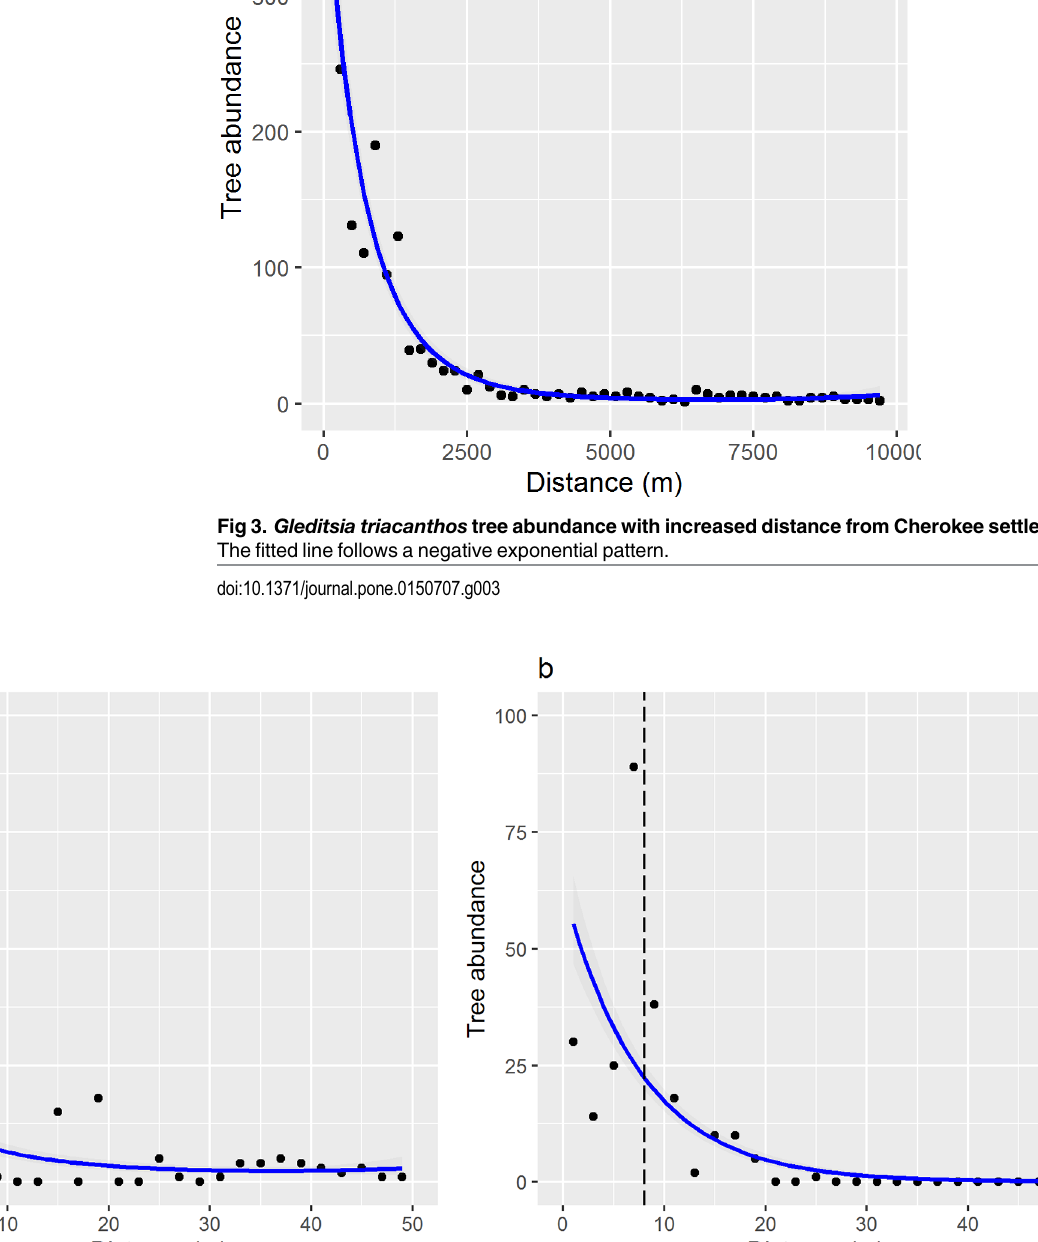
PLOS ONE | DOI:10.1371/journal.pone.0150707 March 16, 2016 10 /